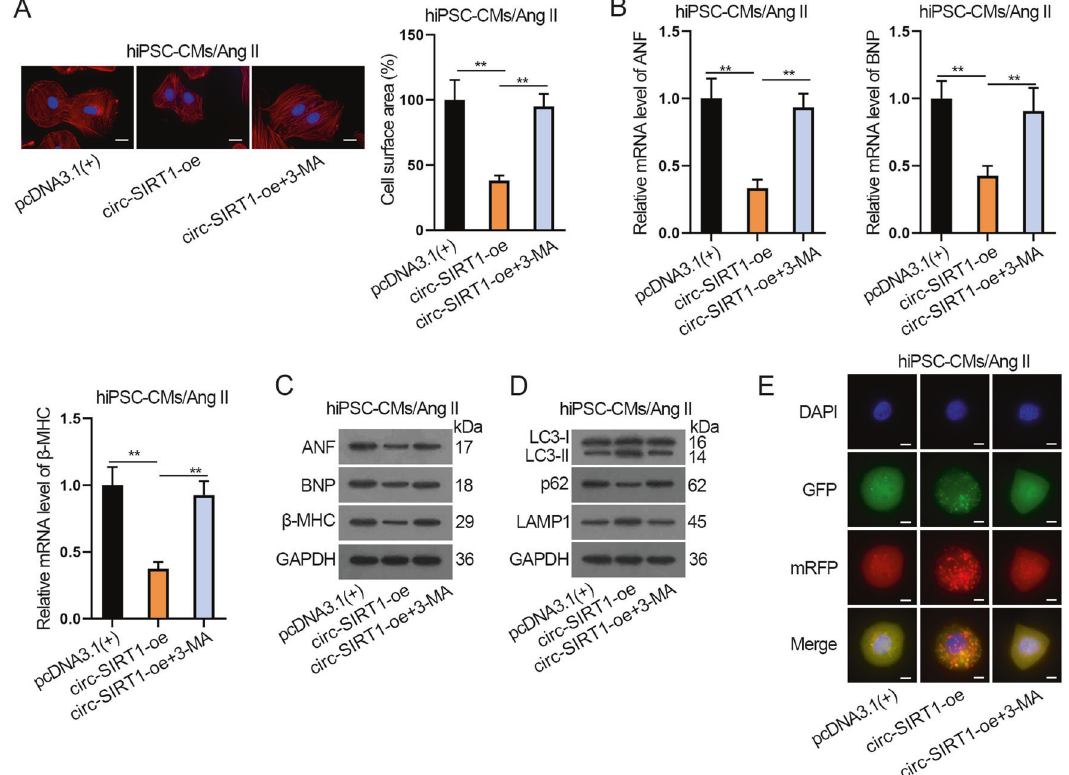
Fig. 3 Circ-SIRT1 suppresses CH by promoting autophagy in hiPSC-CMs. A Analysis of the cell surface area via immuno fl uorescence staining after Ang II-infused hiPSC-CMs transfected with pcDNA3.1( + ) or circ-SIRT1-oe or circ-SIRT1-oe plus treatment with 3-MA (autophagy inhibitor). Scale bar, 10 μ m. N = 3. B , C The expressions of CH markers in Ang II-infused hiPSC-CMs of the above-mentioned groups were determined by RT-qPCR and western blot analyses. N = 3. D , E Autophagy was measured via western blot analysis of autophagy-related proteins and immuno fl